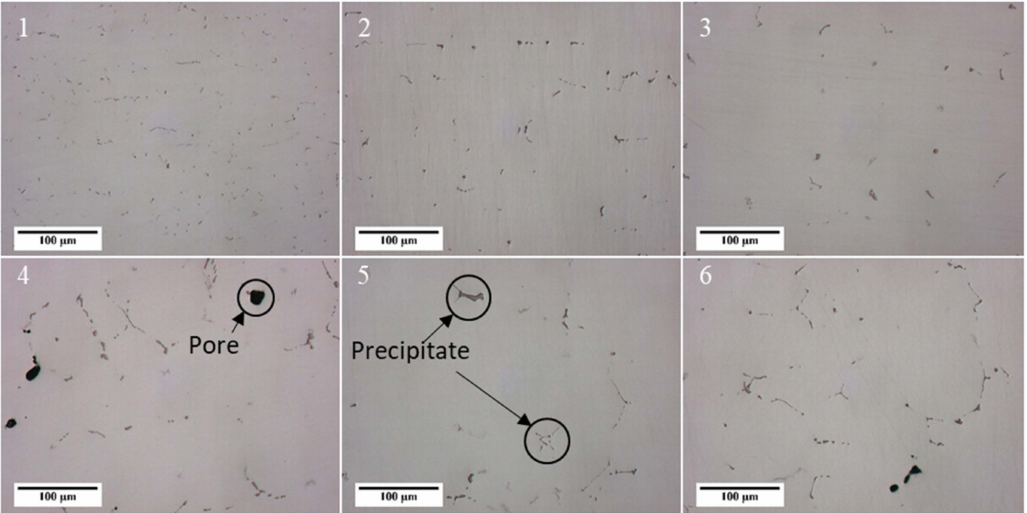
Figure 3. LOM images showing the precipitations as seen in polished samples from the surface to the center of the billet, at the distances; ( 1 ) 5 mm, ( 2 ) 15 mm, ( 3 ) 30 mm, ( 4 ) 45 mm, ( 5 ) 60 mm and ( 6 ) 70